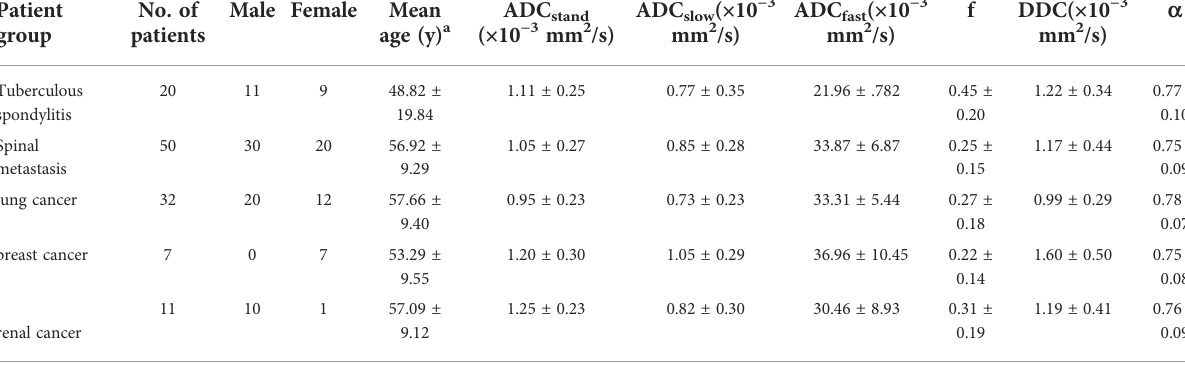
TABLE 1 Patient demographics and IVIM parameters among patients with tuberculous spondylitis and spinal metastasis. Patient